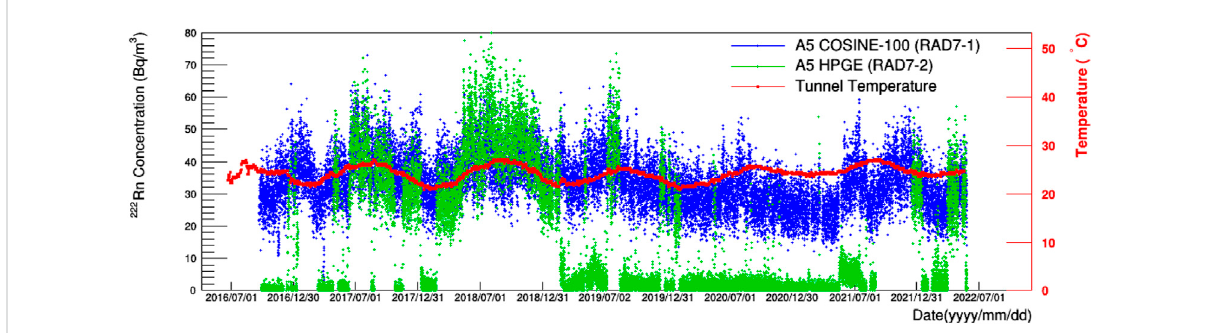
FIGURE 5 The 222 Rn concentration in the HPGe room (green) and the COSINE-100 (blue), which are separated by a distance of approximately 35 m, are compared.Thetwodetectorroomsaremonitoredbythesamemodel(RAD7)detector.Theoccasionalreductionintheradonconcentrationlevelat HPGewascaused bytheoccasionalsupply ofradon-freeairto itsdetectorroom.FordayswhentheRRSwasoff,twodetectorroommeasurements werecorrelated,implyingthatthefundamentalradonactivityisthesameinbothplaces.Thetunneltemperature(red),independentlymeasured outside of the detector rooms in between two rooms, is displayed with a right ordinate label.